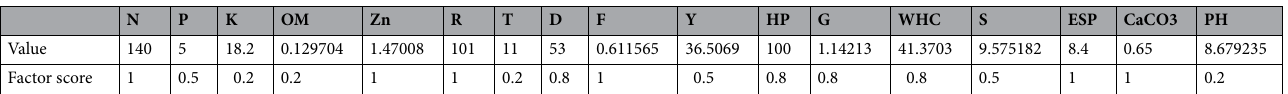
Table 5. Node1 factor scores determination.